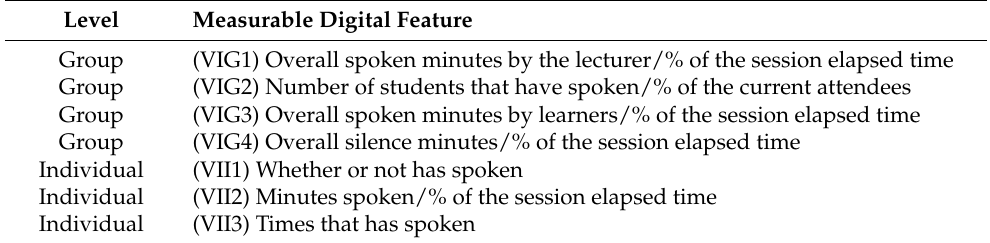
Table 9. Set of digital features defined for the “voice interactions” category, corresponding to features B4, B11, B13 and B18.